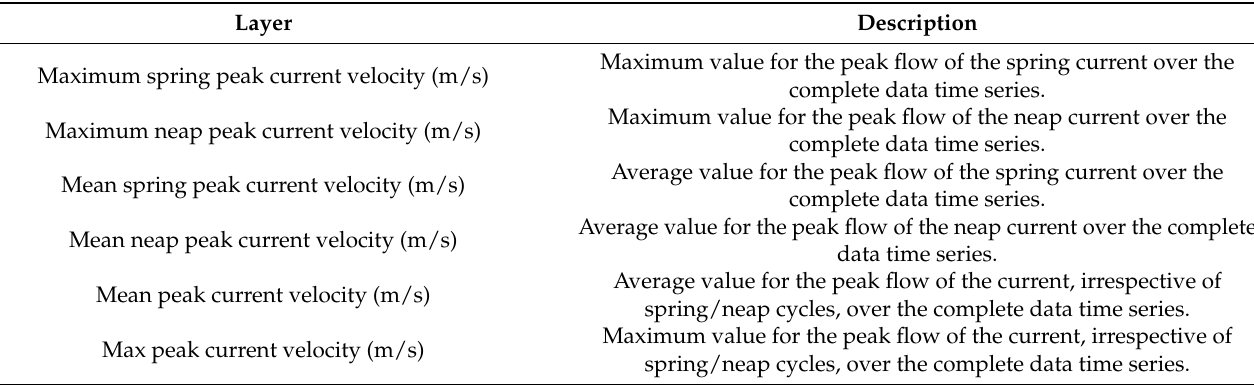
Table 4. The tidal layers and their descriptions as created for the Oceanography group layer. Layer